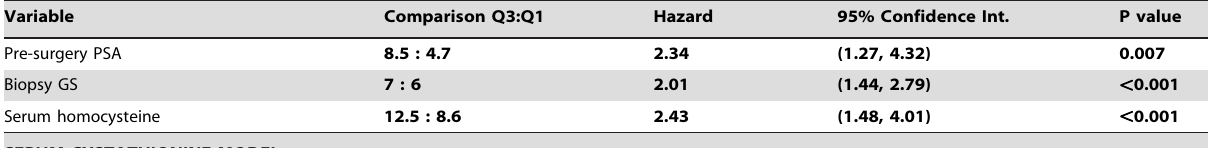
Table 7. Cox regression